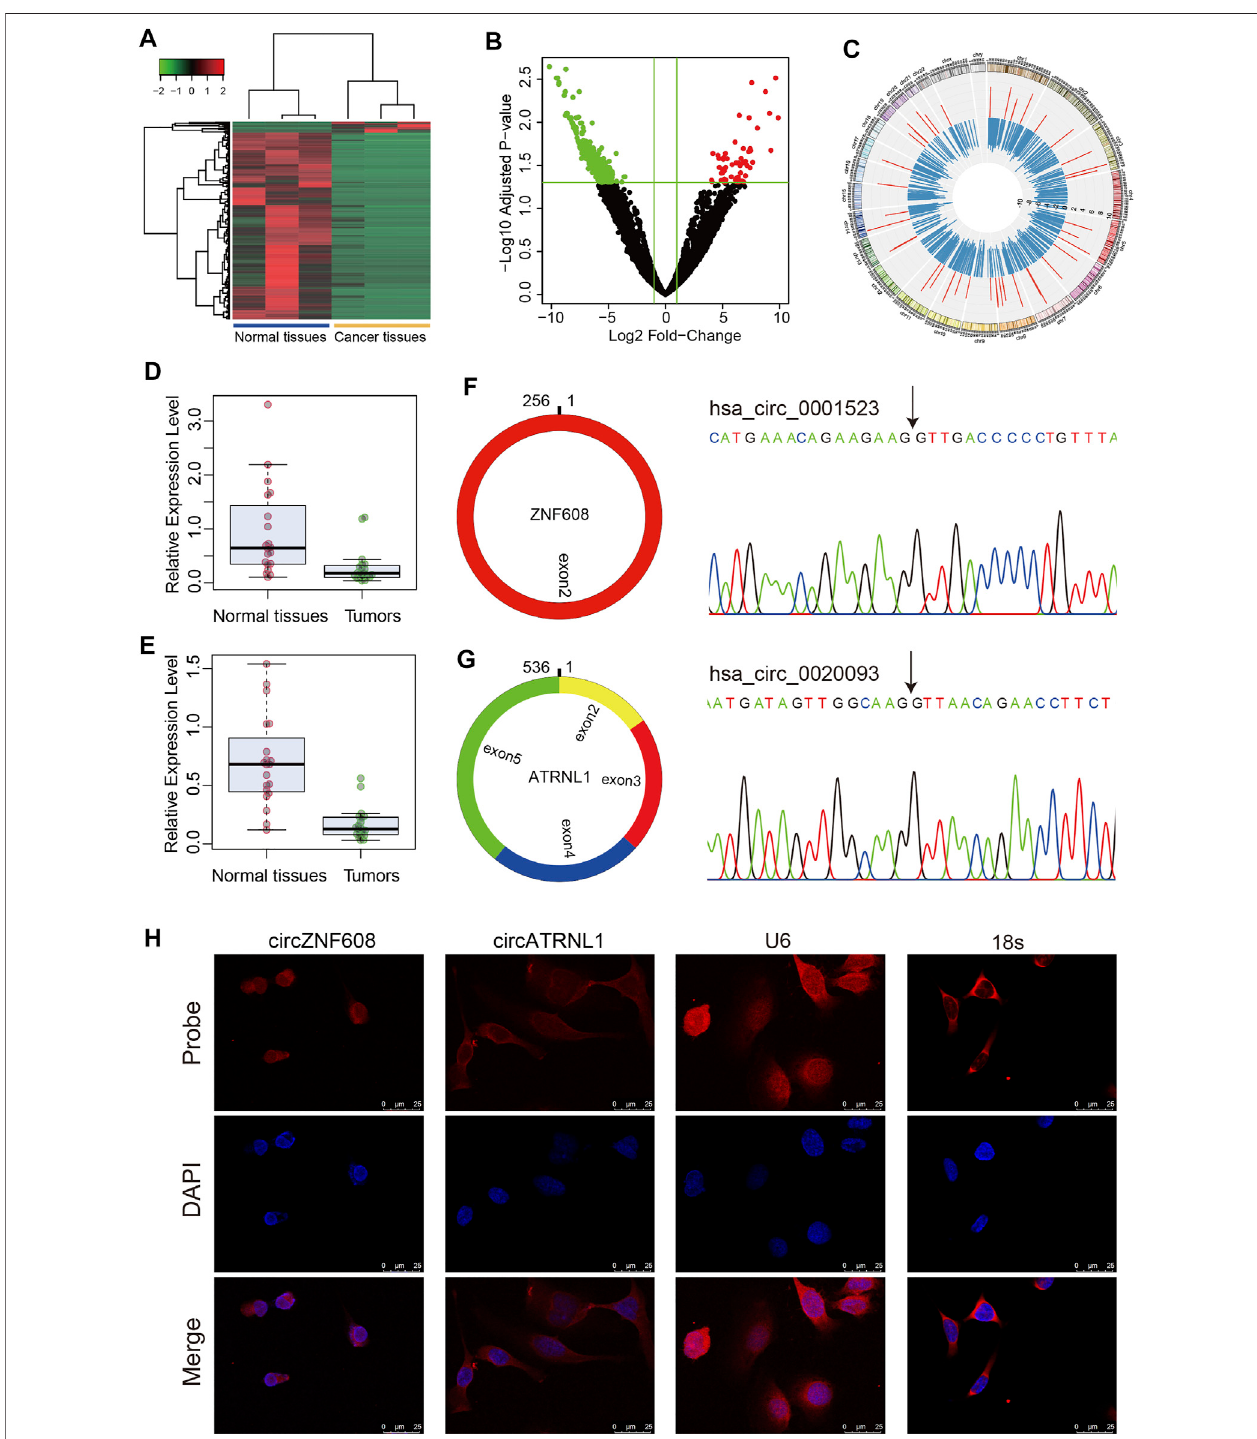
FIGURE 1 | Characteristics of circZNF608 and circATRNL1. (A) Heatmap of differentially expressed circRNAs in ovarian cancer tissues compared with normal ovariantissues. (B) VolcanoplotofcircRNAsinRNA-seqdata.Greendots:downregulatedcircRNAs;reddots:upregulatedcircRNAs. (C) Circosdiagramillustratingthe fold change of differentially expressed circRNAs in RNA-seq data. The red bar indicates log2 (fold change) of upregulated circRNAs, and the blue bar indicates downregulatedcircRNAs. (D) circZNF608and (E) circATRNL1weredownregulatedinovariancancertissuescomparedwithnormalovariantissues( p < 0.001). (F) and (G) Theback-splicejunctionofcircZNF608andcircATRNL1wascon fi rmedbysequencingthePCRproductsfromtheRNaseR-treatedRNA. (H) RNA fl uorescence in situ hybridization for circZNF608 and circATRNL1. Nuclei were stained with 4,6-DAPI.